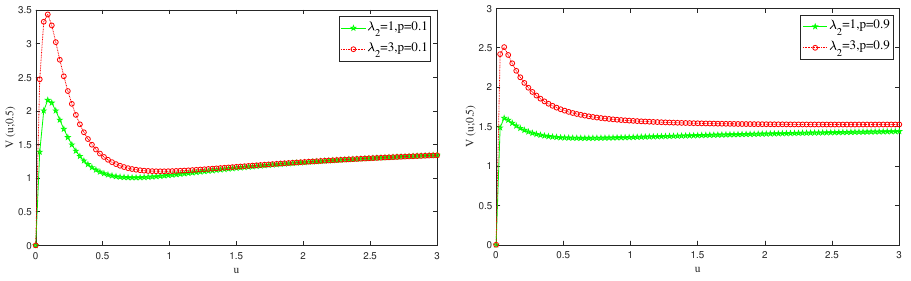
Figure 1. Images of V ( u ;0.5 ) when N = 10, ˆ α = 1